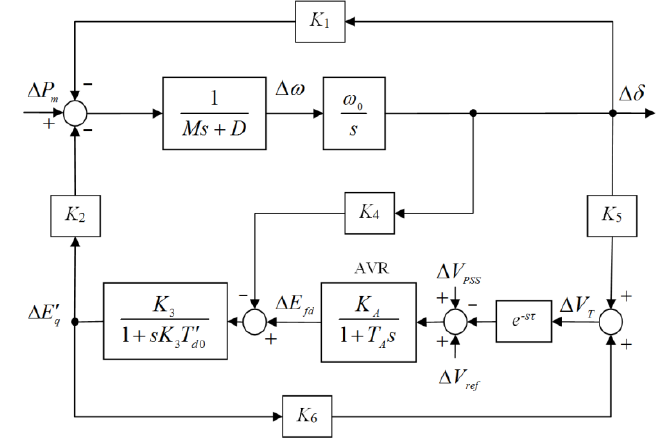
Figure 3. The block diagram of a single-machine-infinite-bus power system with AVR and PSS.